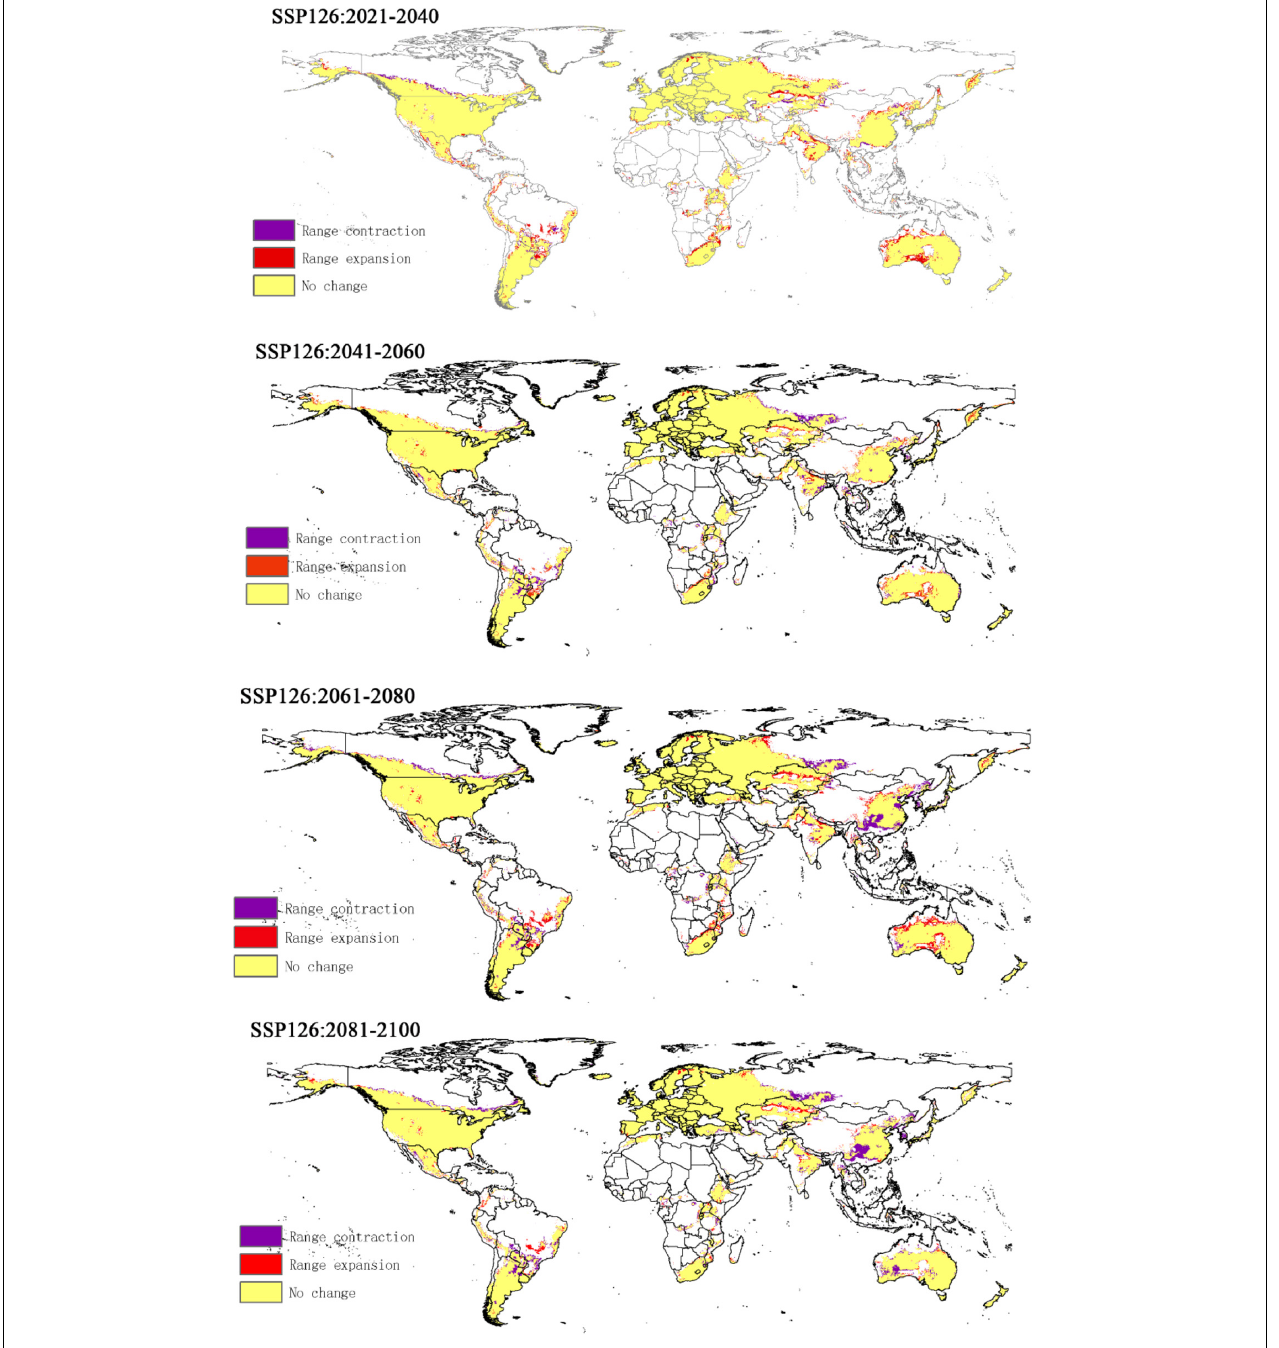
FIGURE 7 | The change of suitable distribution area of CPB under SSP126 climate